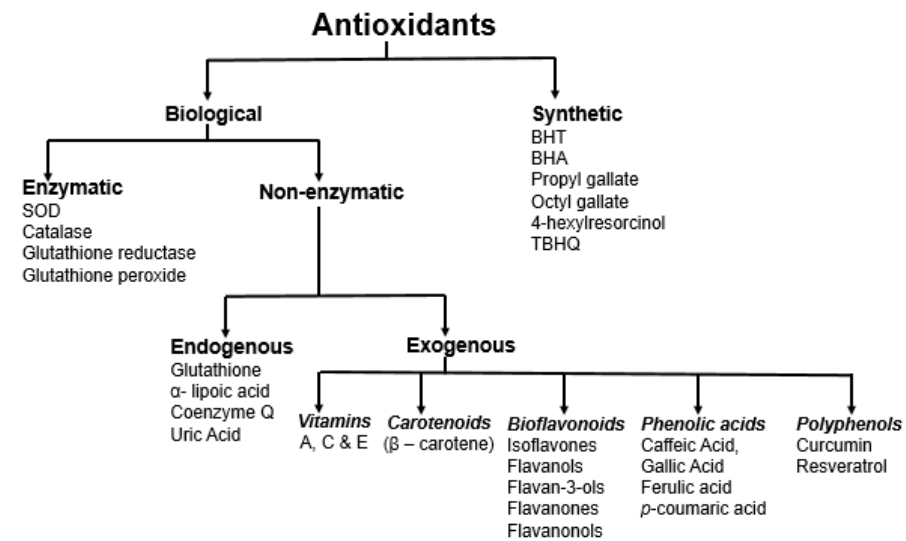
Figure 2. Different approaches for the classification of antioxidants.